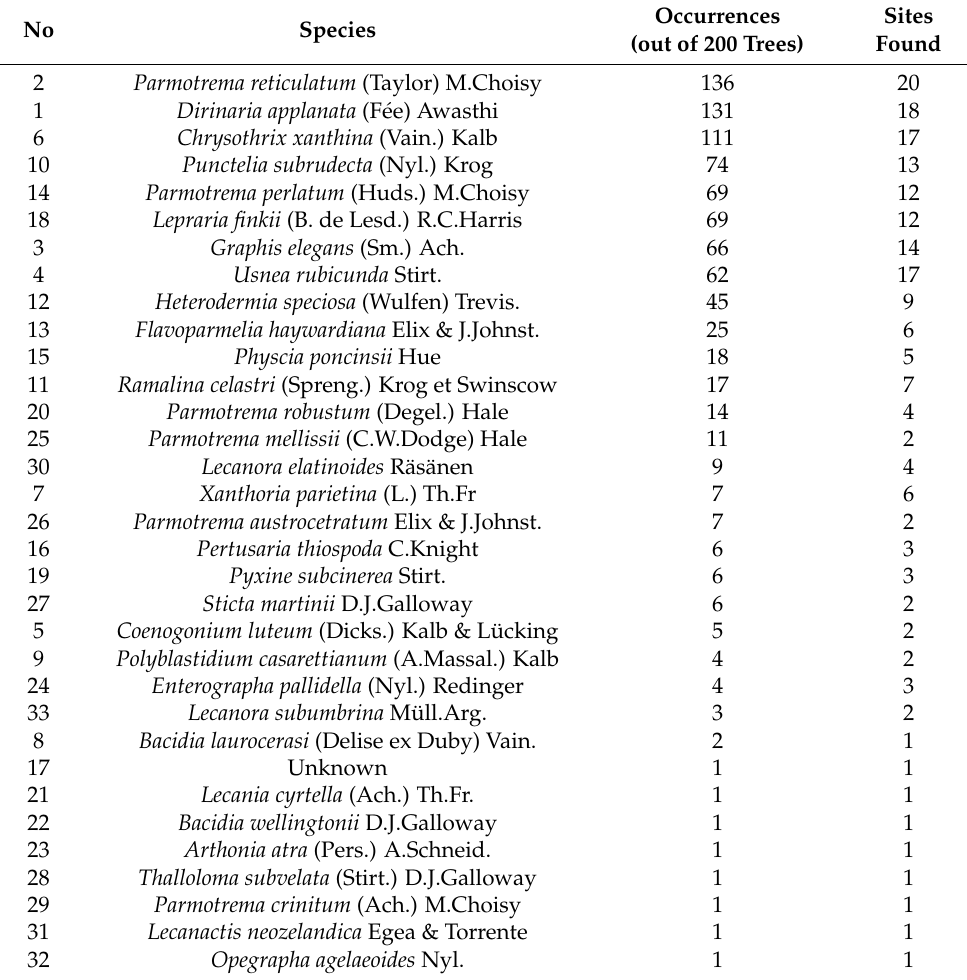
Table 2. Count of species with the number of sites at which they were found.